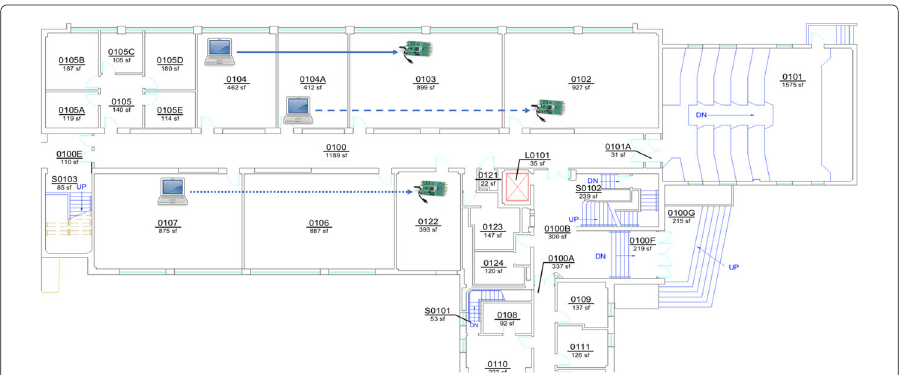
The baseband DMRS signal was generated with the OpenLTE implementation at [38]. The receiver, which is on the right, has one antenna and simply recorded the received baseband samples to be processed by ParEst. In the experiments, the carrier frequency was 915 MHz. The sample rate was 2 M samples per second. The sender used 36 resource blocks (RB) with a total of 432 subcarriers. As the FFT size for the baseband signal was 2048, the link occupied 0.42 MHz of